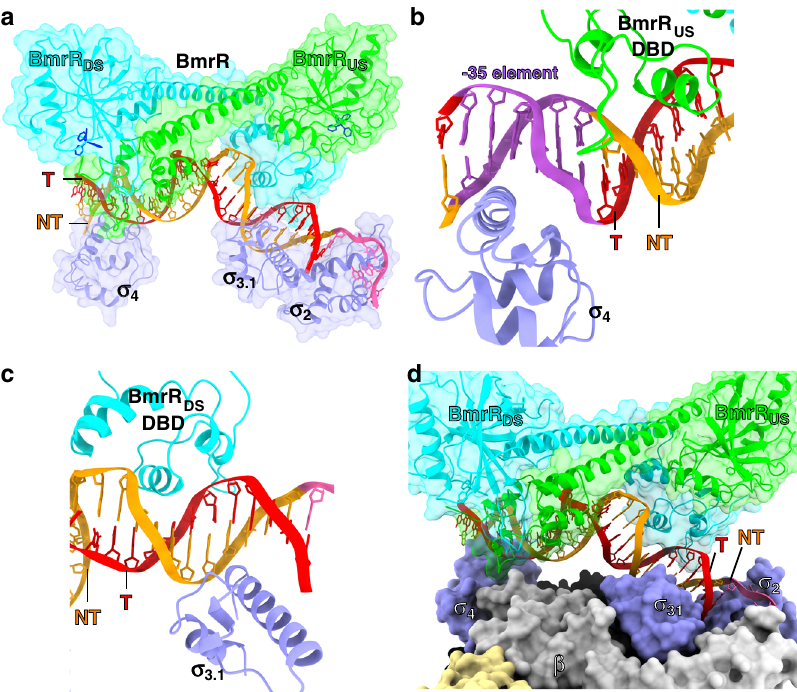
Fig. 3 Cooperative recognition of promoter DNA by BmrR and RNAP. a The upstream promoter dsDNA is fully protected by BmrR and σ A (surface and cartoon presentation). b BmrR US and σ A 4 protects the upstream half of BmrR operator at opposite DNA faces. c BmrR DS and σ A 3.1 protect the downstream half of BmrR operator at opposite DNA faces. d BmrR has little contact with RNAP- σ A holoenzyme. The colors are as in Fig. 1.